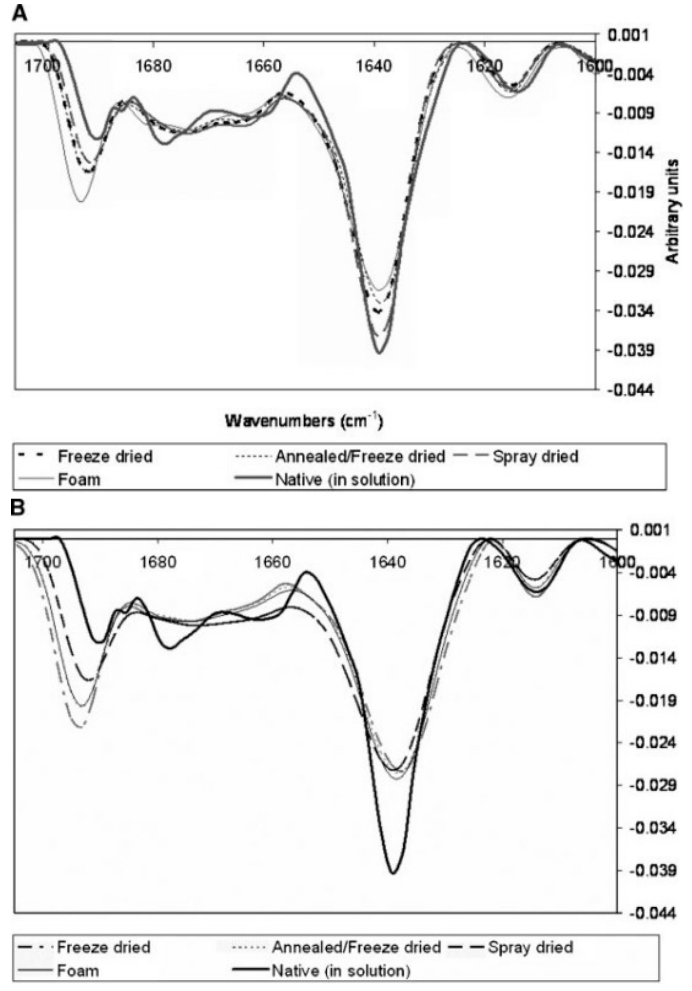
Figure 3. Second derivative FTIR spectra of immunoglobulin G1 (IgG1) in solid form in two different formulations with sucrose—sucrose:IgG1 = 4:1 ( A ) and sucrose:IgG1 = 1:4 ( B ). Formulations with higher sucrose content show better stability and thus preservation of the native secondary structure. Reproduced with permission from [33], Wiley, 2007.